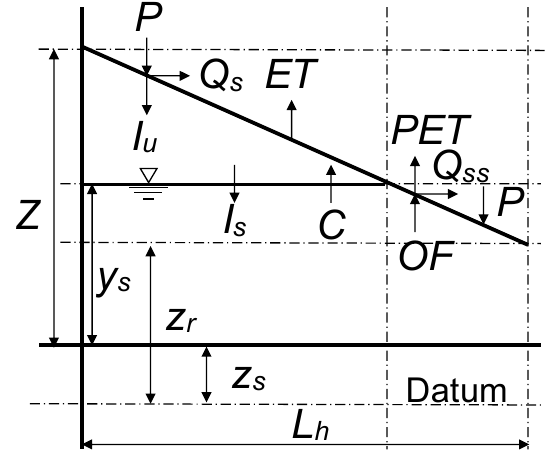
Fig. 1. Conceptual drawing of Reggiani et al.’s (2000) REW-scale water balance model: P : Precipitation, ET: Evapotranspiration, Figure 1. 3 PET: Potential evapotranspiration, Q s : Surface runoff, Q ss : Sub- surface runoff, I u : Infiltration from the ground surface, I s : Infil- tration to the saturated zone, C : Capillary rise, OF: Outflow from saturated zone, Z : Average elevation of ground surface from datum, z r : Average elevation of channel bed with respect to datum, z s : Av- erage elevation of the bottom surface of the REW with respect to datum, y s : Average thickness of saturated zone, L h : Averaged hor- izontal length of one side of